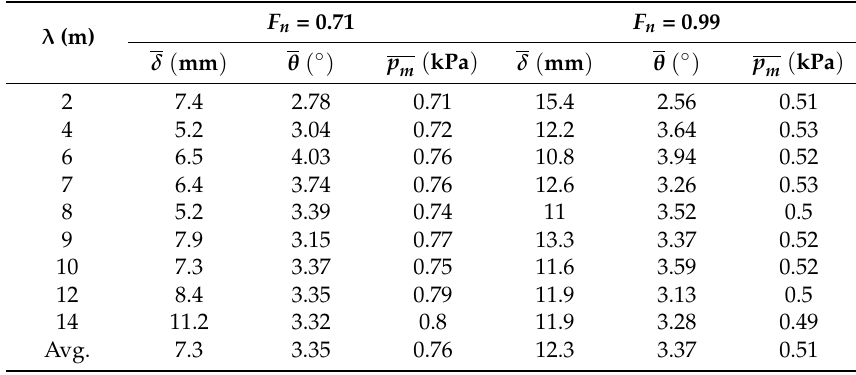
Table 2. Navigation attitude in various cushion Froude numbers.